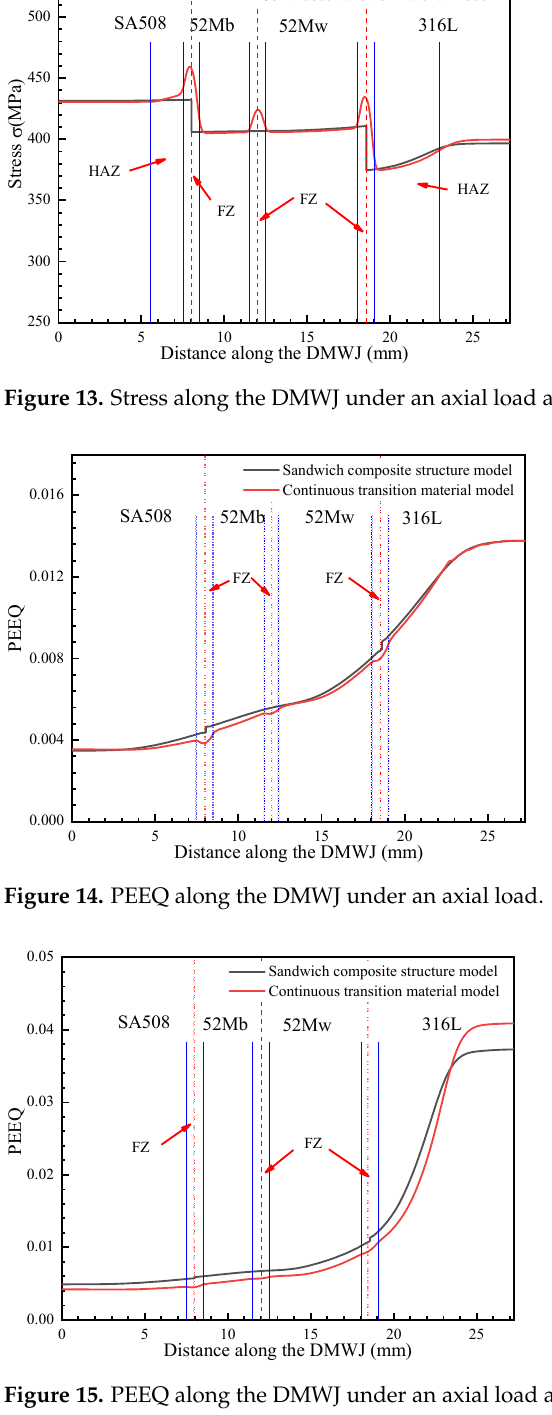
Figure 15. PEEQ along the DMWJ under an axial load and internal pipe pressure.